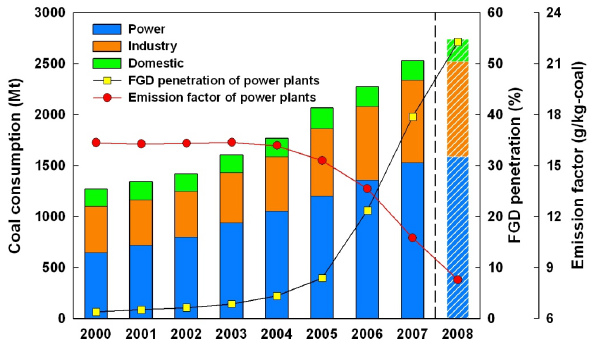
Fig. 1. Coal consumption by sector, average FGD penetration of power plants, and average emission factor of power plants in China during 2000–2008. The data for the year 2008 are extrapolated based on national fast-track